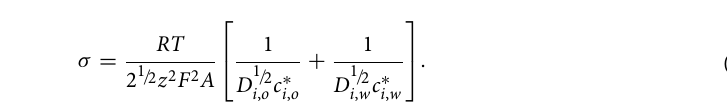
Figure 4. The measured (markers) and the fitted (solid line) Nyquist diagrams acquired using Cell 1 with 0 ( A ), 5 ( B ), and 20 mM ( C ) of TT added to the DCE phase as well as 5 mM of CuSO 4 (aq). Spectra were obtained with a direct applied potential ( V DC ) of ~ 0.7 V after performing one CV cycle using the potential range shown in Fig. 2 with v = 0.020 V s –1 ; similarly, in-between each spectrum in B and C a CV pulse was applied. ( D ) equivalent electric circuits (EEC) for a simple ion transfer (EEC1) or coupled electron and ion transfer during electro-generation (EEC2) of the thin film at an ITIES, such that R s , R CT , and R C , are the solution, charge transfer, and kinetic resistance, while CPE1 and CPE2 are constant phase